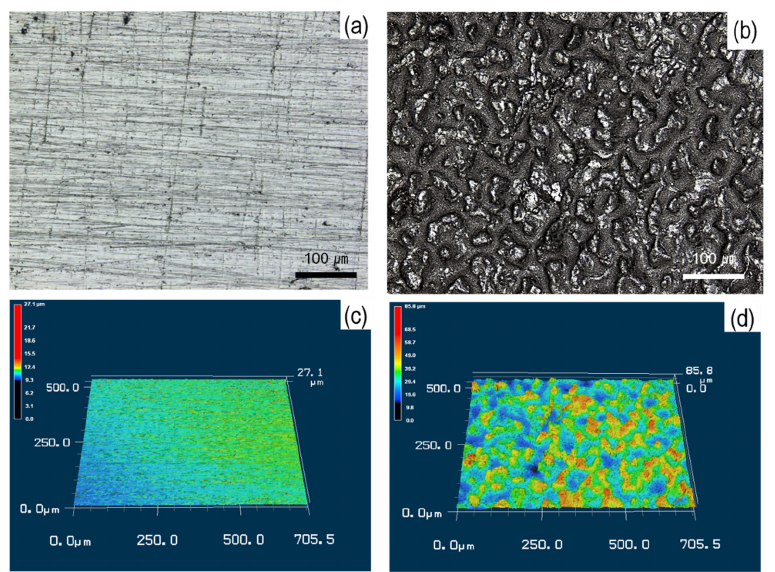
Figure 5. Surface and 3D images for surface topography before and after the coating process; ( a – c ) substrate and ( b – d ) coated surface. Table 2. Average roughness (R a ), peak-to-valley roughness (R z ) and root-mean-square roughness (R q ) determined by 3D microscope. Substrate